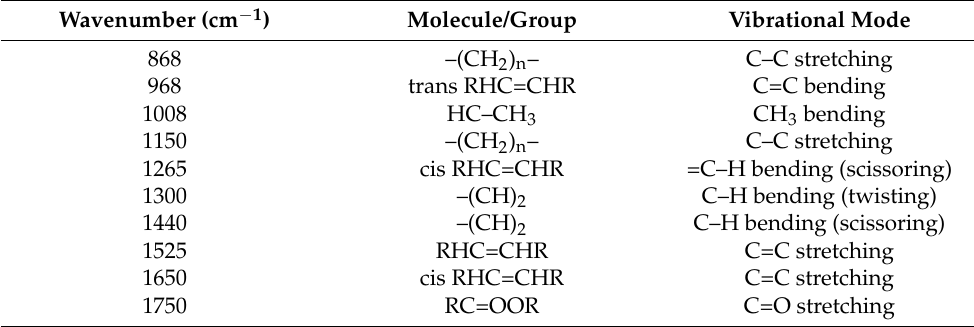
Table 2. Assignment of major Raman peaks in EVOO and other edible oils in the